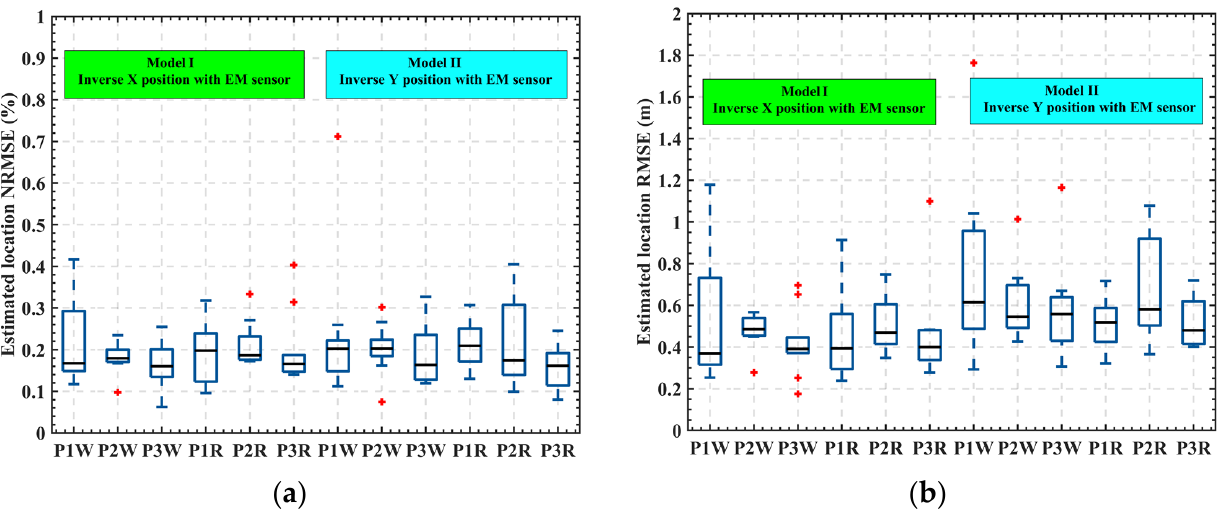
Figure 12. Error statistics results: ( a ) NRMSE statistics and ( b ) RMSE statistics.